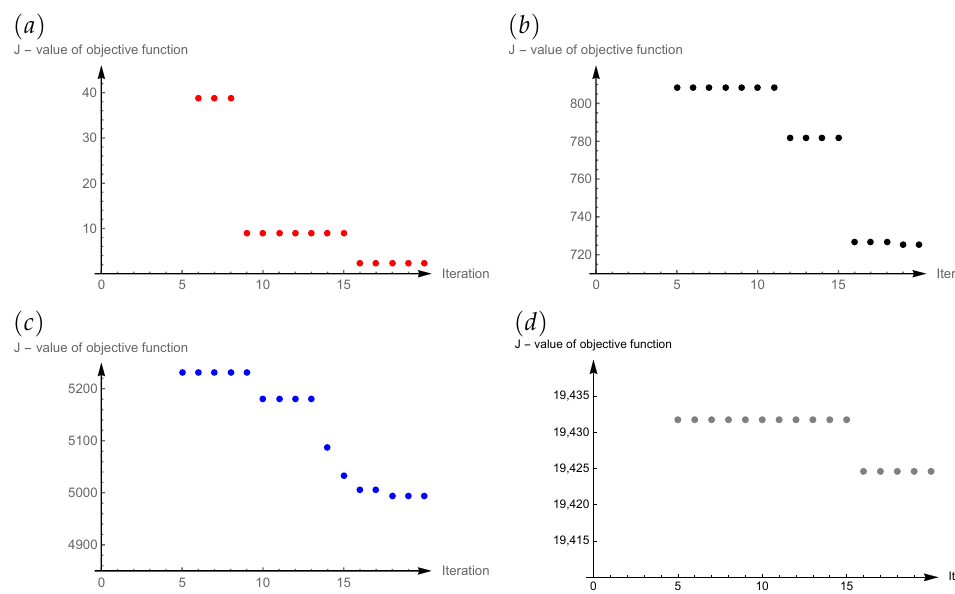
Figure 3. Values of objective function J in iterations of ACO algorithm for different levels of input data noise: ( a ) 0%, ( b ) 2%, ( c ) 5%, ( d )